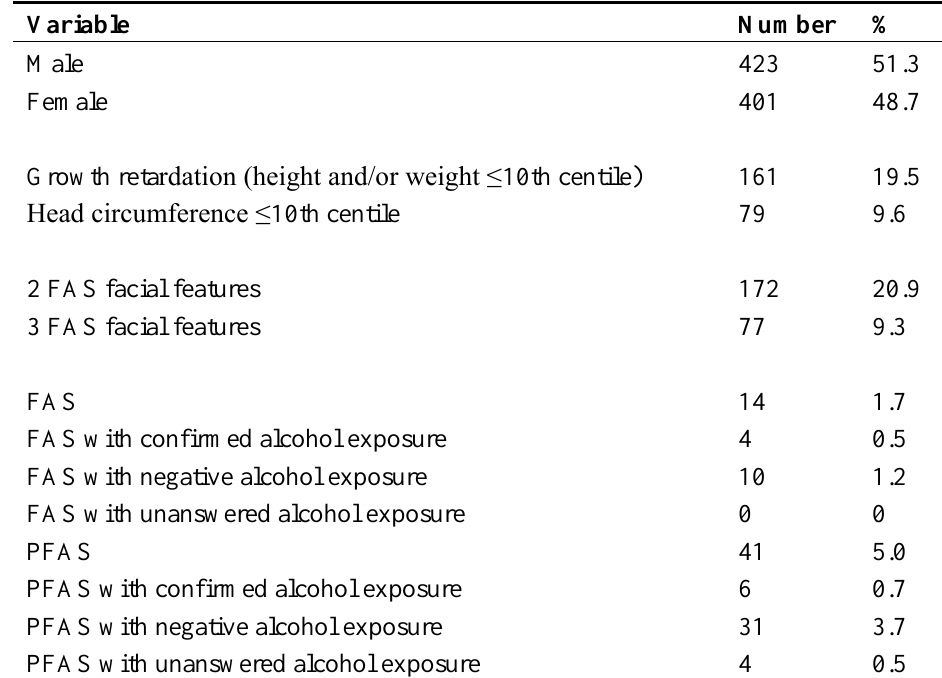
Table 2. Clinical characteristics in a sample of 824 examined